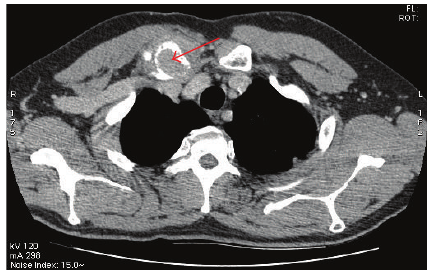
Figure 1: Bone metastasis in the sternoclavicular joint invading adjacent soft tissues.